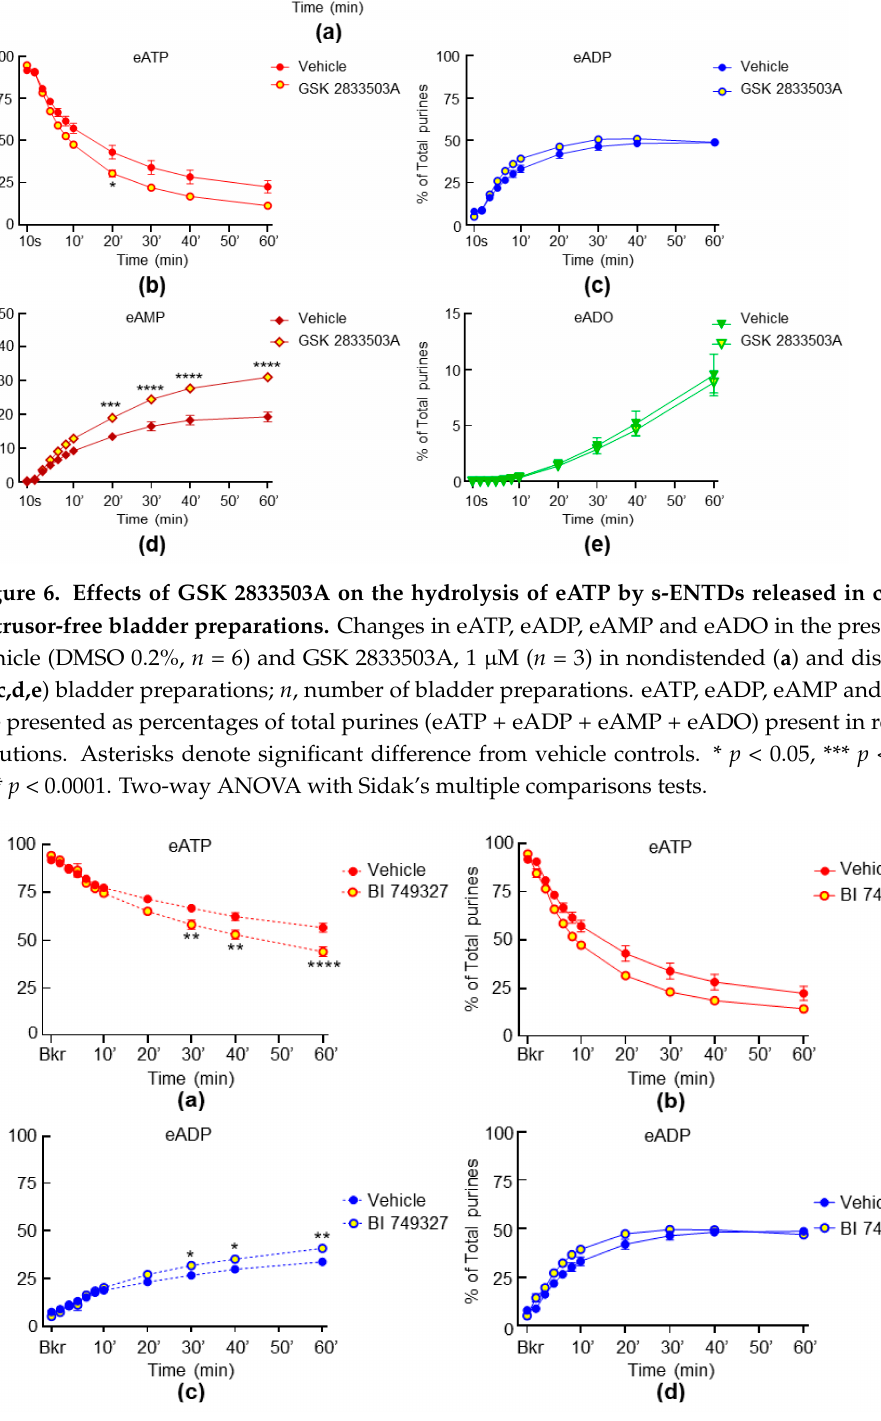
Figure 7. E ff ects of BI 74932 on the hydrolysis of eATP by s-ENTDs released in cELS of non- distended and distended detrusor-free bladder preparations. Changes in eATP, eADP, eAMP and eADO in the presence of vehicle (DMSO 0.2%, n = 6) and BI 74932, 1 µM ( n = 3) in nondistended ( a , c , e , g ) and distended ( b , d , f , h ) bladder preparations; n , number of bladder preparations. eATP, eADP, eAMP and eADO are presented as percentages of total purines (eATP + eADP + eAMP + eADO) present in reaction solutions. Asterisks denote signi fi cant di ff erence from vehicle controls. * p < 0.05, ** p < 0.01, *** p < 0.001, **** p < 0.0001. Two-way ANOVA with Sidak’s multiple comparisons tests. 2.6. Inhibition of Receptors for Sensory Neuropeptides A ff ects Di ff erentially the Release of s- ENTDs in LP We next investigated whether selective antagonists of NK2 and PAC1 receptors in- fl uence the release of s-ENTDs in LP. Neither the spontaneous nor the distention-induced release of s-ENTDs was altered in the presence of the NK2 receptor antagonist MEN 10376 (Figure 8a,b). However, a greater degradation of eATP was observed in the presence of the PAC1 receptor antagonist PACAP6-38 in the cELS of distended preparations (Figure 9). Thus, the decrease of eATP and the increase of eAMP were signi fi cantly greater at 20 –